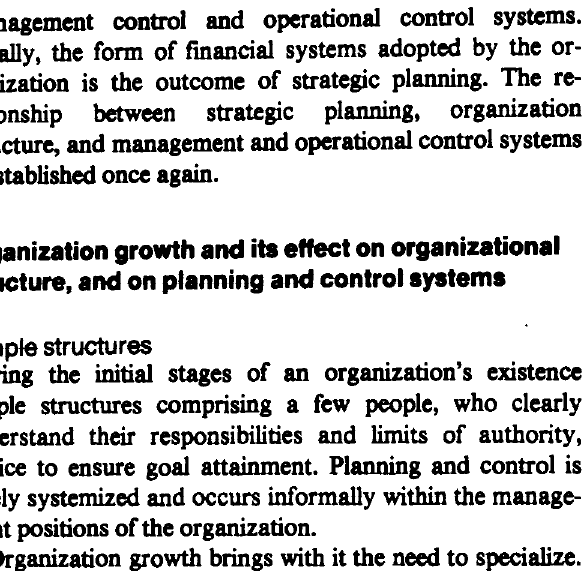
Complex structures